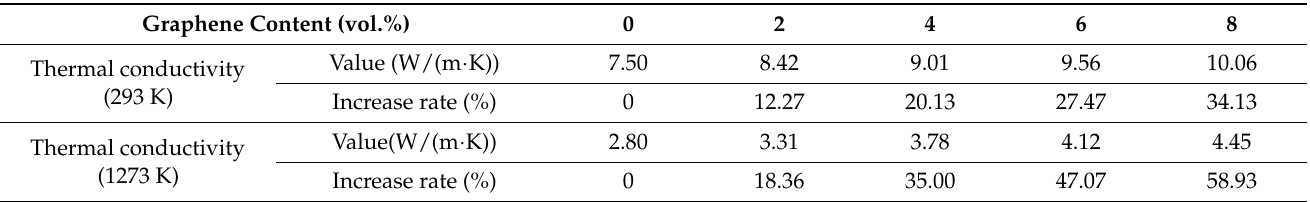
Table 3. Relationship between graphene content and thermal conductivity of